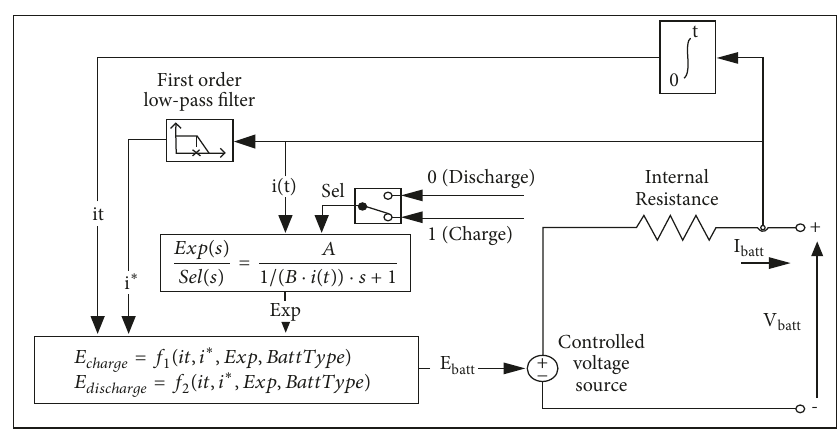
Figure 13: Dynamic model for Li-ion battery [15].